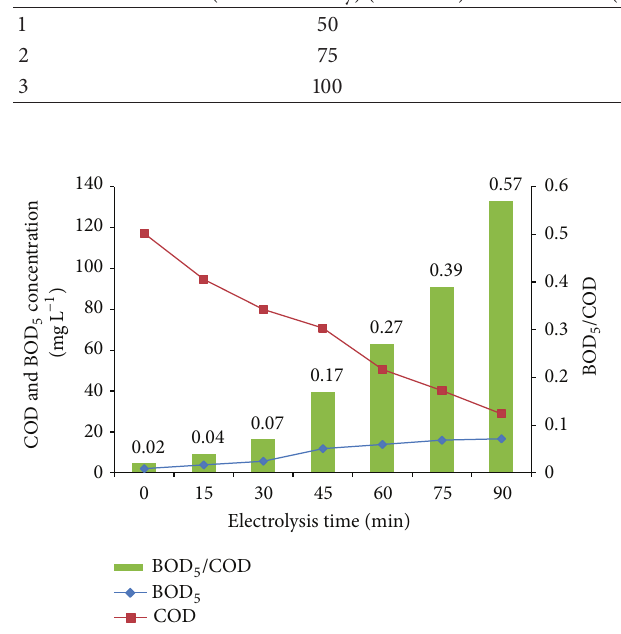
Figure 5: COD, BOD 5 , and BOD 5 /COD of quinoline effluent at different electrolysis